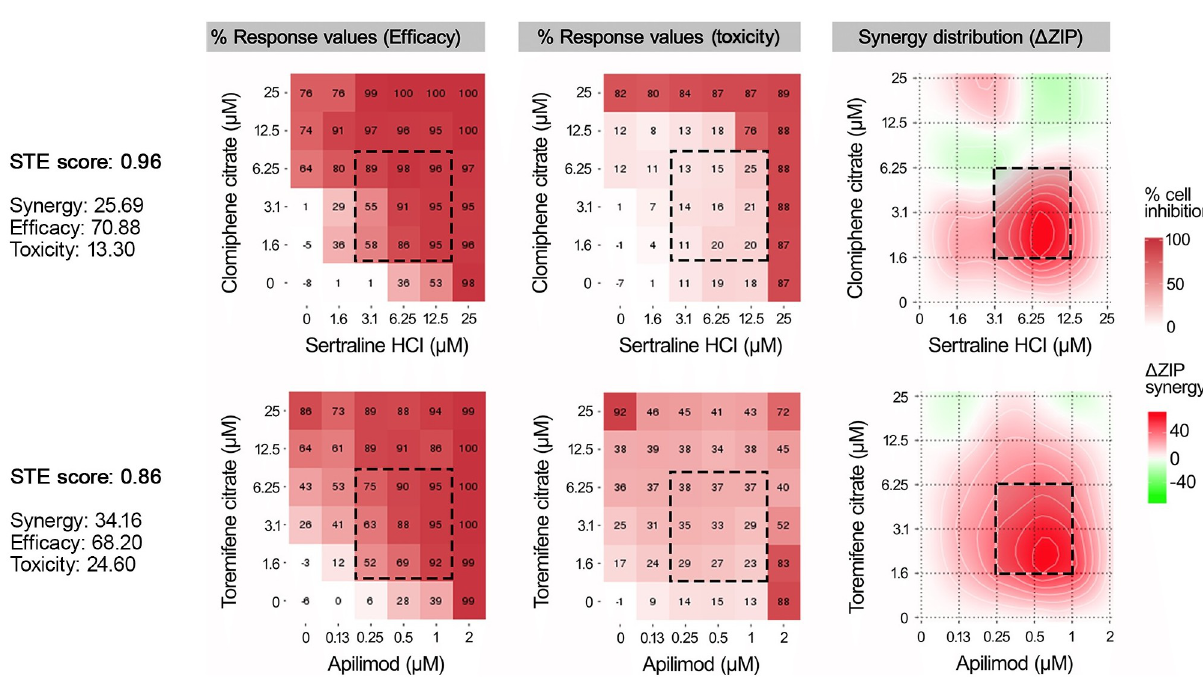
Fig 3. SynToxProfiler penalizes for toxicity of drug pairs while ranking top hits. The efficacy, toxicity, and synergy matrices for the top drug pairs selected based on the highest STE score (clomiphene citrate and sertraline HCL, upper panel) and the highest synergy score (toremifene citrate and apilimod, lower panel). The synergy was calculated using the ZIP model implemented in SynergyFinder [21]. The square with dotted line denotes the 3x3 concentration range with the most synergistic area in the dose-response matrix.